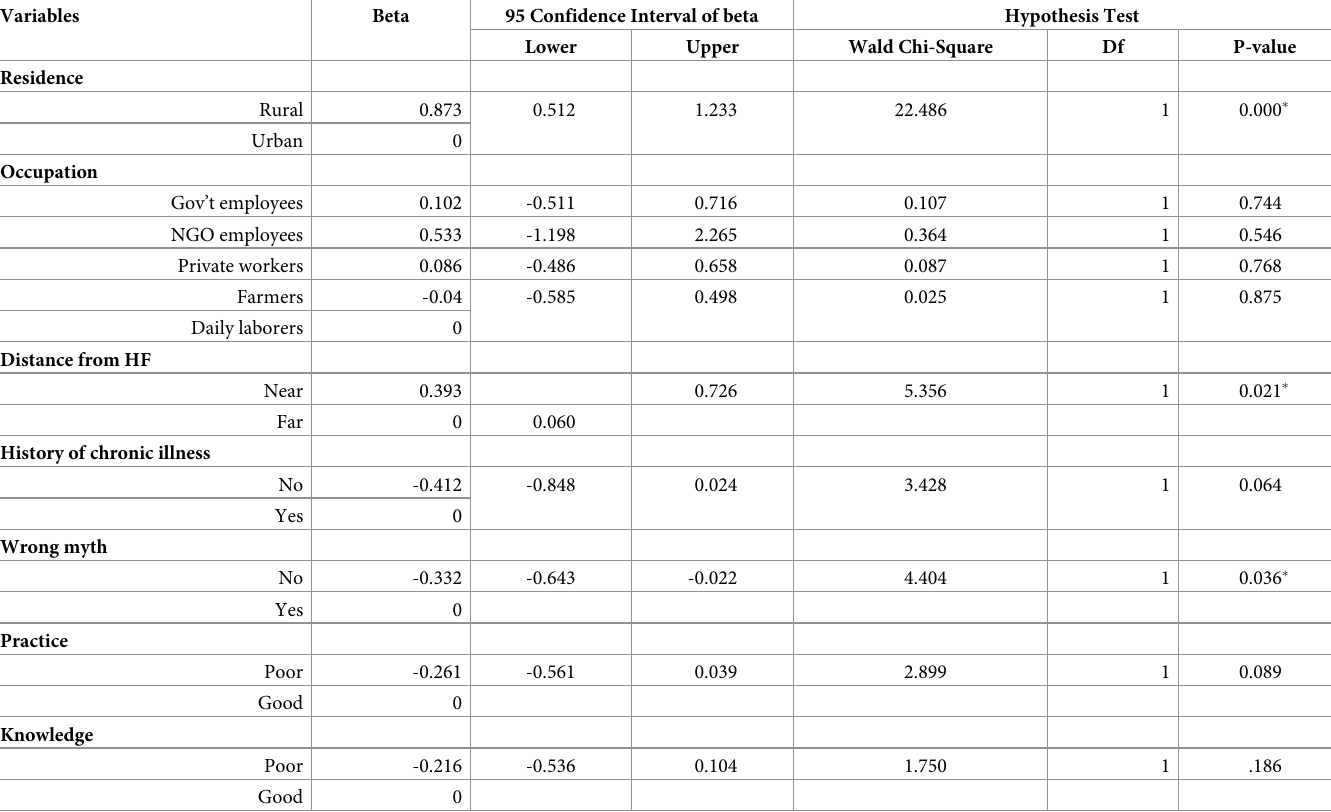
Table 3. Generalized linear model results of factors associated with risk perception towards COVID-19 pandemic in East Bale and Bale Zone Southeast